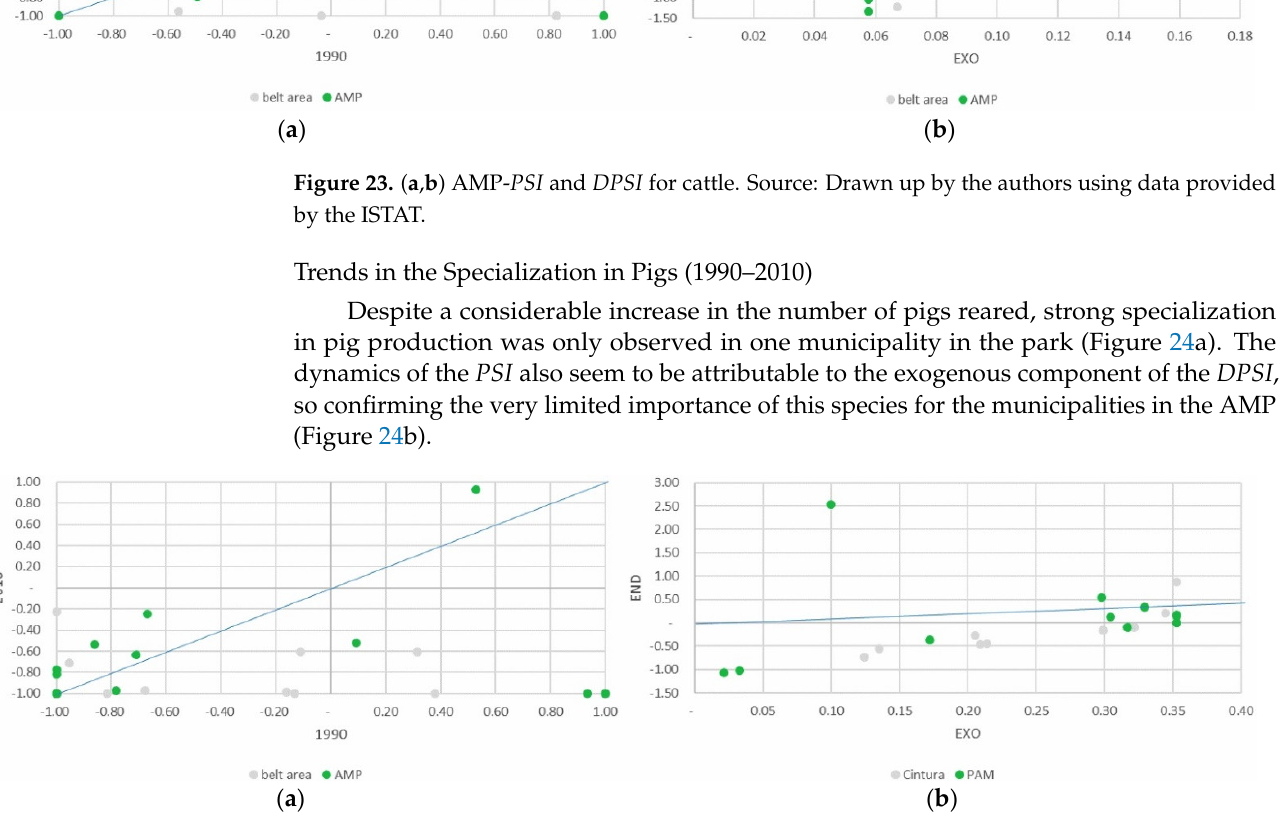
Figure 24. ( a , b ) AMP- PSI and DPSI for pigs. Source: Drawn up by the authors using data provided by the ISTAT.